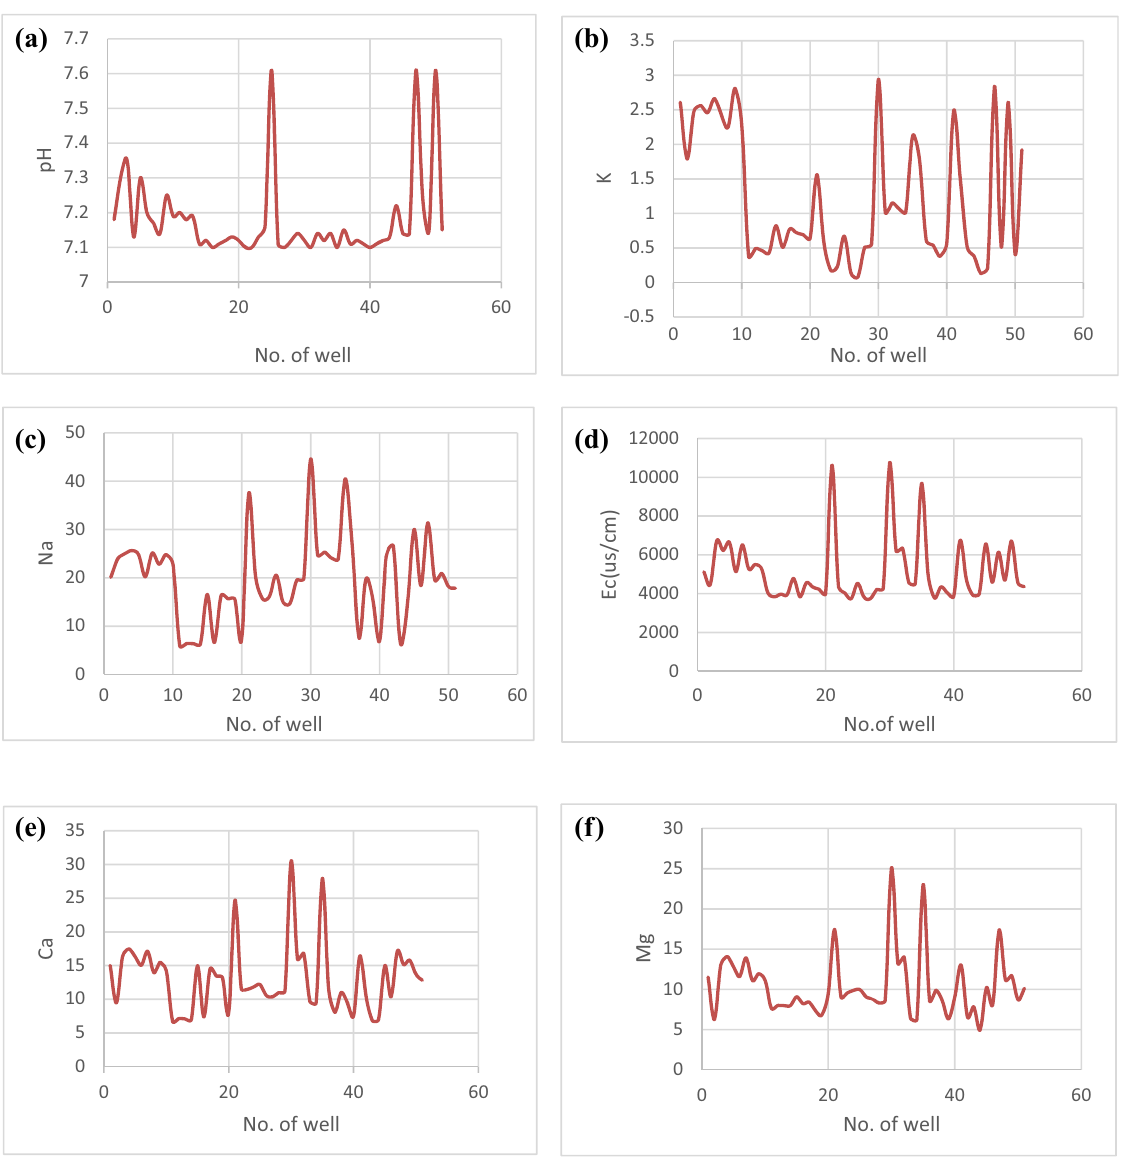
Figure 3: The variation of input variables in ANNs model. ( a ) The measured data of pH from observation wells. ( b ) The measured data of K from observation wells. ( c ) The measured data of Na from observation wells. ( d ) The measured data of EC from observation wells. ( e ) The measured data of Ca from observation wells. ( f ) The measured data of Mg from observation